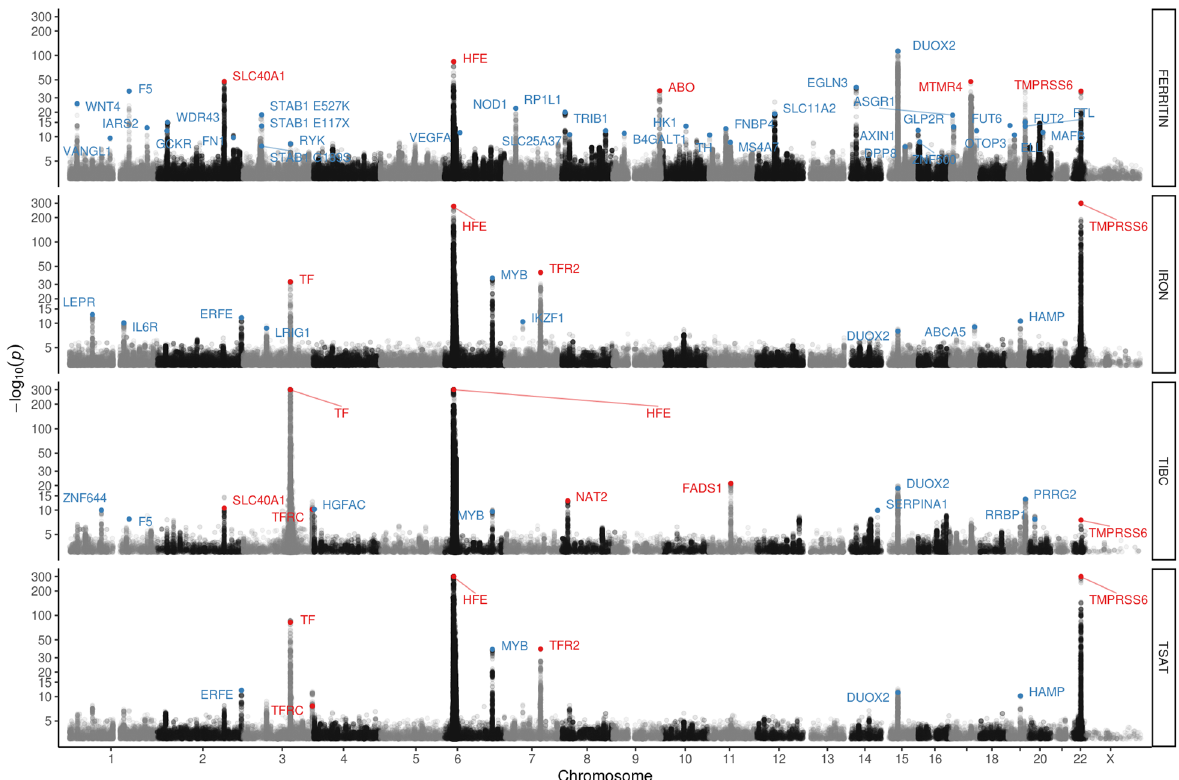
Fig. 2 Manhattan plots for iron homeostasis biomarker meta-analysis results for ferritin ( N = 246,139), serum iron ( N = 163,511), total iron-binding capacity (TIBC, N = 135,430), and transferrin saturation (TSAT, N = 131,471). Variants are plotted by chromosomal position ( x -axis) and − log10 P values ( y -axis). A likelihood ratio test was used when testing for the association. Blue = novel loci (not reported in previous iron GWAS studies), red = previously reported loci.